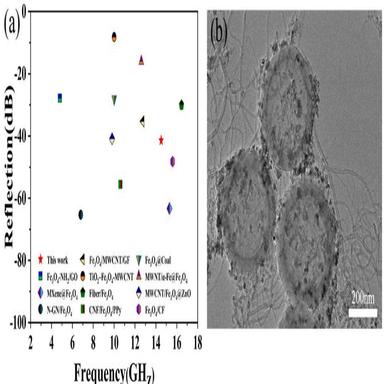
(a) Comparison of the microwave absorbing capability between Fe3O4@PS-2/MWCNT samples and the reported composites that contain nanostructure-Fe3O4 and carbonaceous materials. (b) TEM image of Fe3O4@PS-2/MWCNTs.